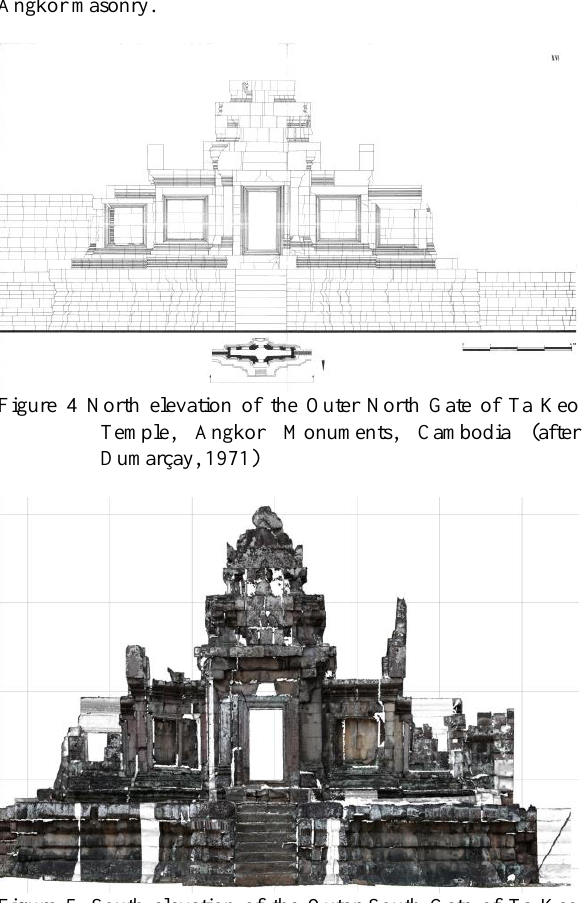
Figure 5. South elevation of the Outer South Gate of Ta Keo Temple, Angkor Monuments, orthophoto based on point cloud